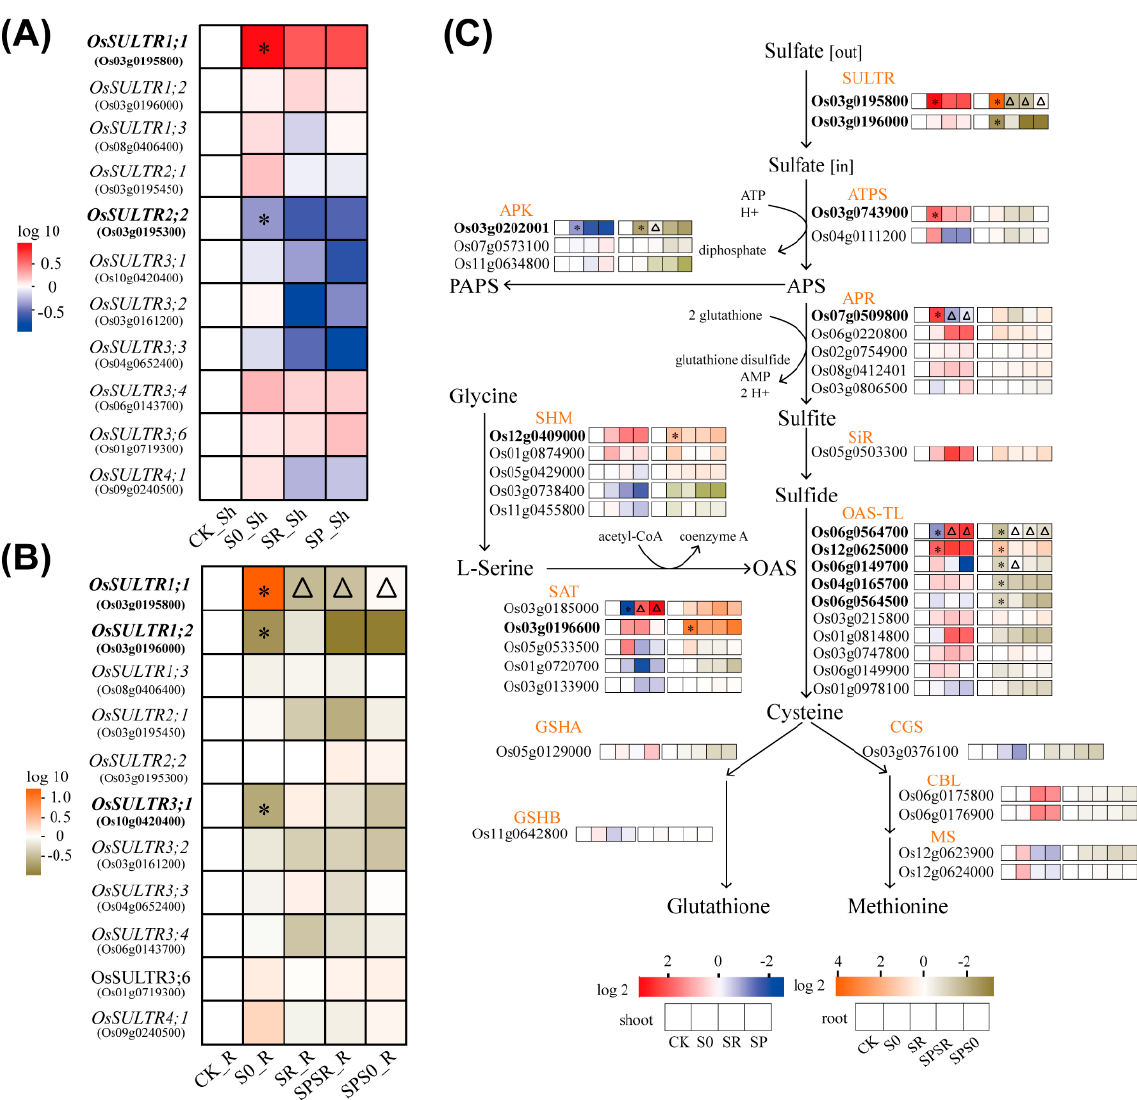
Figure 5. Summary of expression pattern of genes involved in sulfate uptake, assimilation, and metabolism in roots and shoots of plants under various S conditions. ( A ) Relative expression level of sulfate transporter genes in shoots of rice plants under S deficiency or resupplied with sulfate homogeneously or heterogeneously in roots. ( B ) Relative expression level of sulfate transporter genes in roots of rice plants under different S conditions. ( C ) Relative expression level of genes involved in sulfate assimilation and metabolism in roots (right panel) and shoots (left panel) of plants under different S conditions. Relative expression levels in ( A – C ) were normalized to the control (CK). Asterisks (*) represented genes that were significantly differentially expressed under S deficiency. Tri- angles ( ∆ ) represented genes showing local, systemic, or both response to sulfate resupply. SULTR: sulfate transporter; ATPS: ATP sulfurylase; APR: adenosine-5‘-phosphosulfate reductase; APK: adenosine-5’-phosphosulfate (APS) kinase; SIR: sulfite reductase; OAS-TL: O-acetylserine (thiol) ly- ase; SAT: serine acetyltransferase; SHM: serine hydroxymethyltransferase; GSHA: gamma-glu- tamylcysteine synthetase; GSHB: glutathione synthetase B; CGS: cystathionine gamma-synthase; CBL: cystathionine beta-lyase; MS: methionine synthase. CK, control; S0, S deficiency; SR, sulfate resupply in both sides of split-roots; SPSR, the split-root halve with sulfate resupply; SPS0, the split- root halve remained in S deficiency. Sh, shoot; R, root.